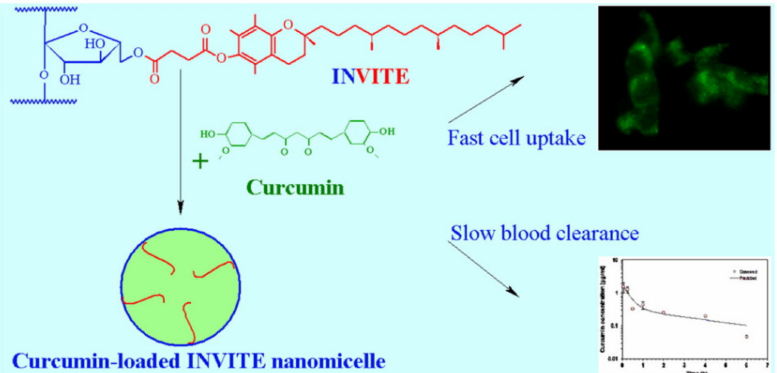
Figure 6. Inulin-D- α -Tocopherol succinate (INVITE) nanomicelles for intravenous administration of curcumin. Reproduced with permission [114]. Copyright 2015, American Chemical